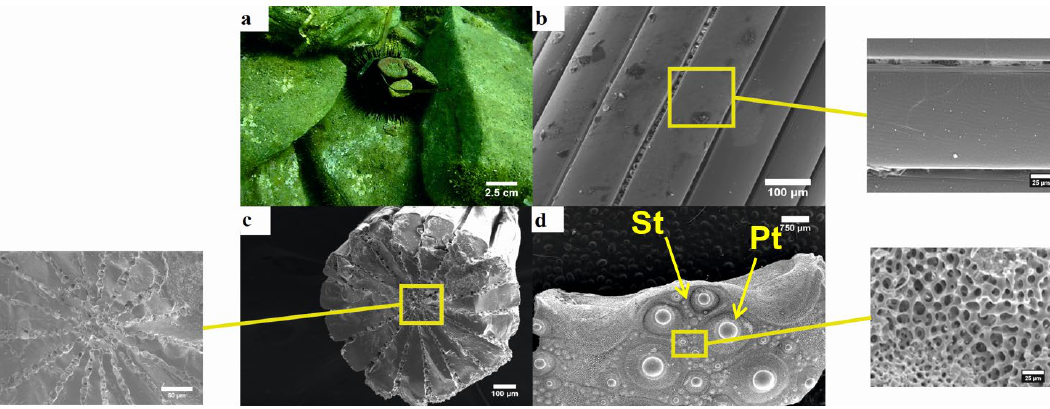
Figure 4. Purple sea urchin Paracentrotus lividus . ( a ) General in situ view of the aboral side; ( b ) longitudinal section of the shaft of the spine (×100), with enlarged image showing a wedge of the spine (×550); ( c ) transverse section of the spine (×100), with enlarged image showing the inner part of the spine. Notice that no porous zone is present; ( d ) section of the test from the peristomal region (×16), with enlarged image showing the stereom of the outer surface (×600). St—secondary tubercles; Pt—primary tubercles.